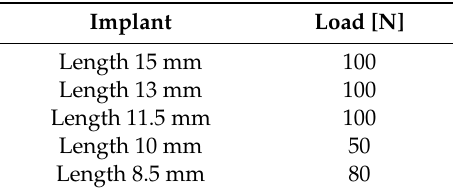
Table 2. Maximum load obtained.